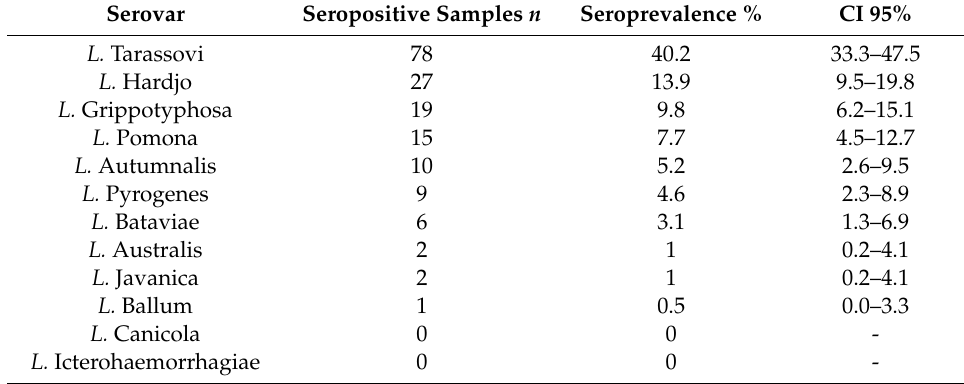
Table 2. Number of seropositive samples and seroprevalence of Leptospira spp. serovars using MAT (titer ≥ 1:100); in total 194 bovine serum samples from central and northern Madagascar were included in the study. Serovar Seropositive Samples n Seroprevalence % CI 95%